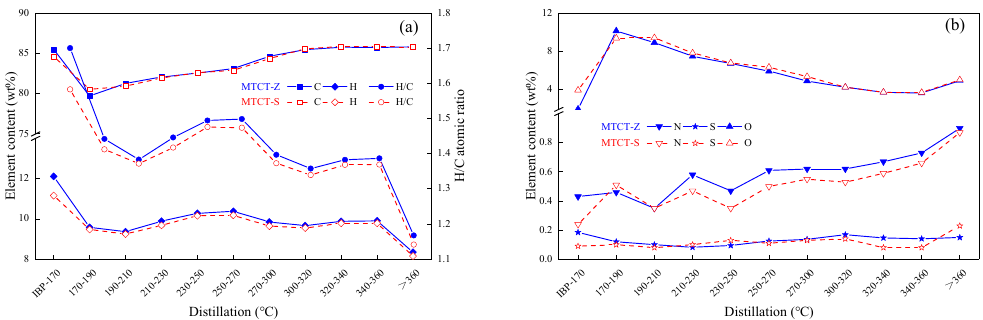
Figure 3. Element composition analysis for narrow distillate fractions of MLCT. ( a ) C, H, C/H, ( b ) N, S, O.